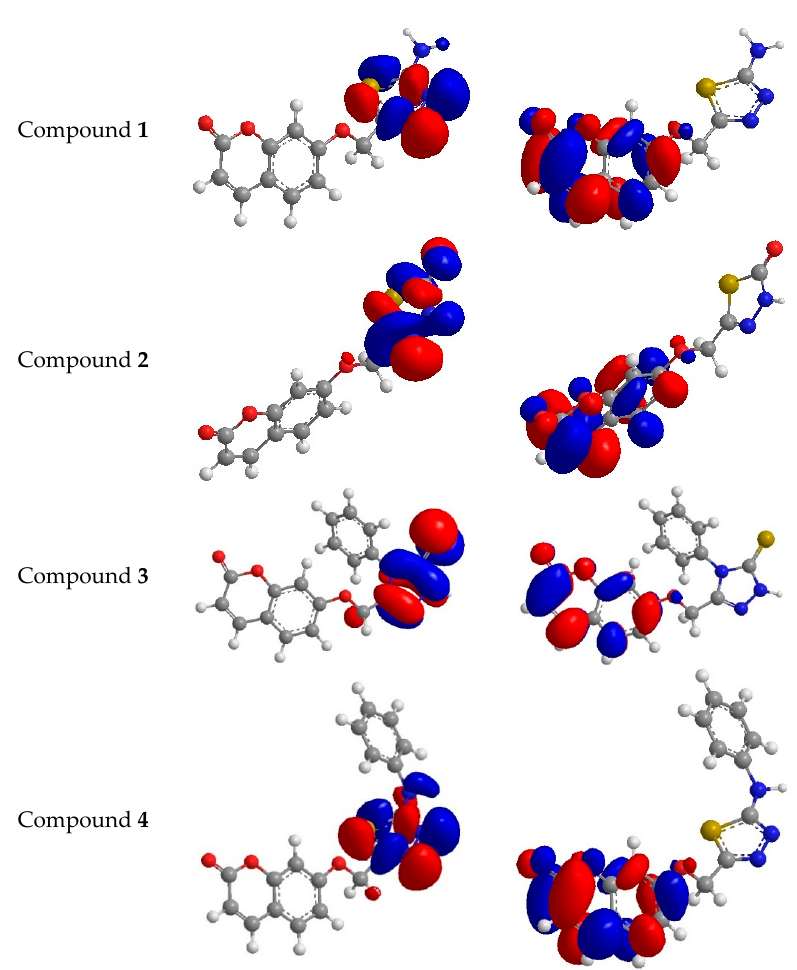
Figure 7. Highest occupied molecular orbital (HOMO) and the lowest unoccupied molecular orbital of compounds 1 – 4 .